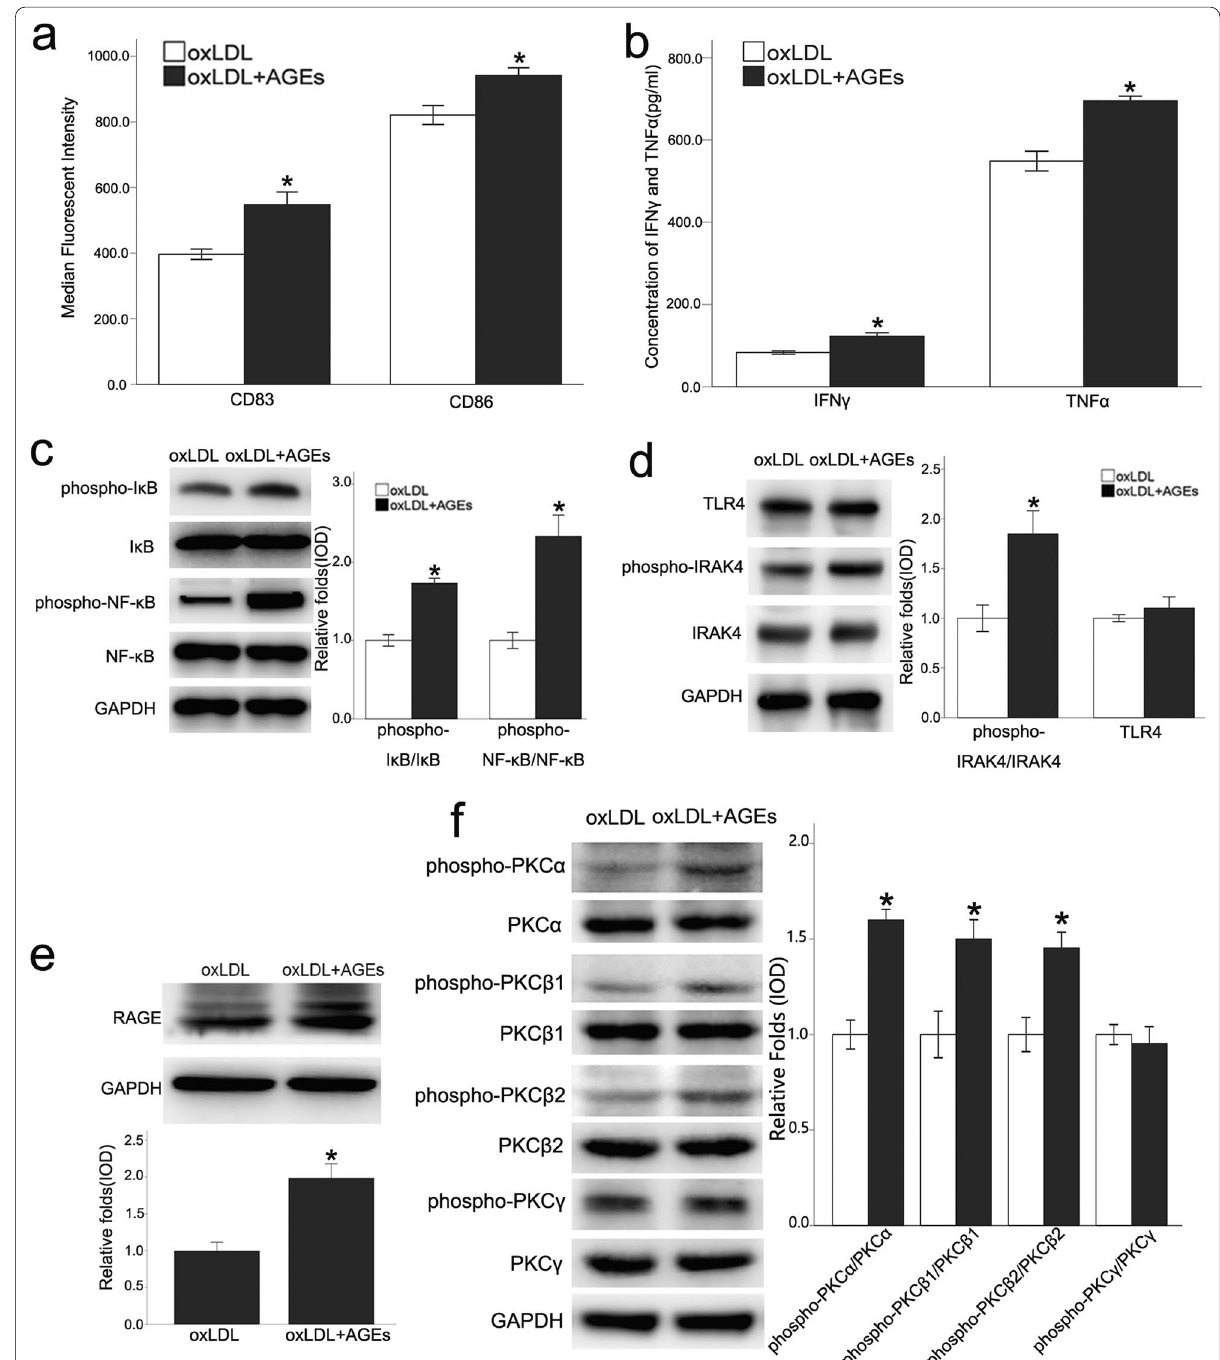
Fig. 2 AGEs plus oxLDL further induced the maturation of DCs and activated certain signaling pathways. The oxLDL plus AGEs treatment increased the expression of CD83 and CD86 ( a ), in BMDCs, and also up-regulated expression of IFNγ and TNFα ( b ), which was demonstrated by ELISA. In conjunction with stimulation by oxLDL, AGEs induced a greater degree of the phosphorylation of IκB, NF-κB ( c ), IRAK4 ( d ), PKCα/β 1 /β 2 ( f ), and the expression of RAGE ( e ). Values, mean SED; n 3, *p < 0.05 vs. oxLDL group; oxLDL oxidized low density lipoprotein, AGEs advanced glycation ± = end-products, TNFα Tumor necrosis factor alpha, IFNγ IFN gamma, NF-κB nuclear factor-κB, RAGE Receptor for advanced glycation end products, pPKC phosphorylated protein kinase C, TLR4 Toll-like receptor 4, IRAK4 Interleukin receptor associated kinase